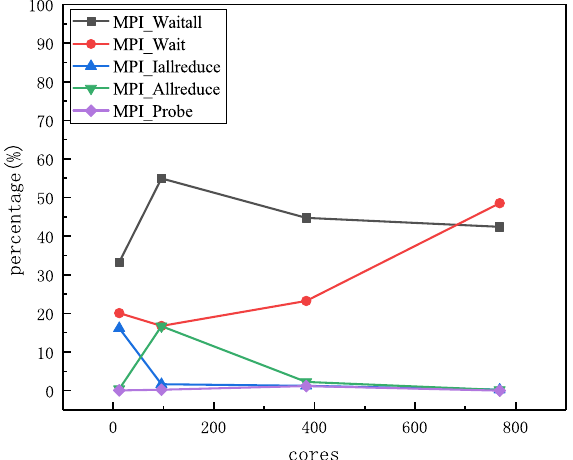
Figure 16. Percentages of key MPI Communication (opt). The test case and its working condition are the same as that in Figure 5.